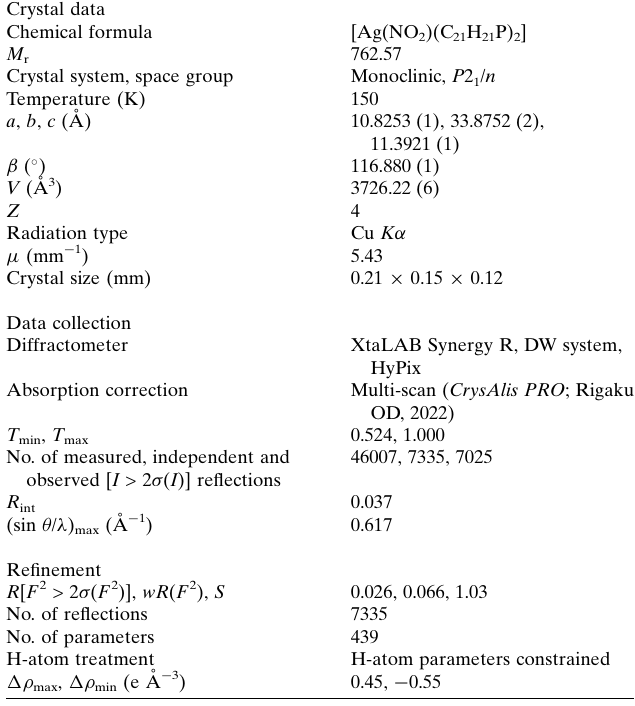
Table 2 Experimental details. Crystal data Chemical formula